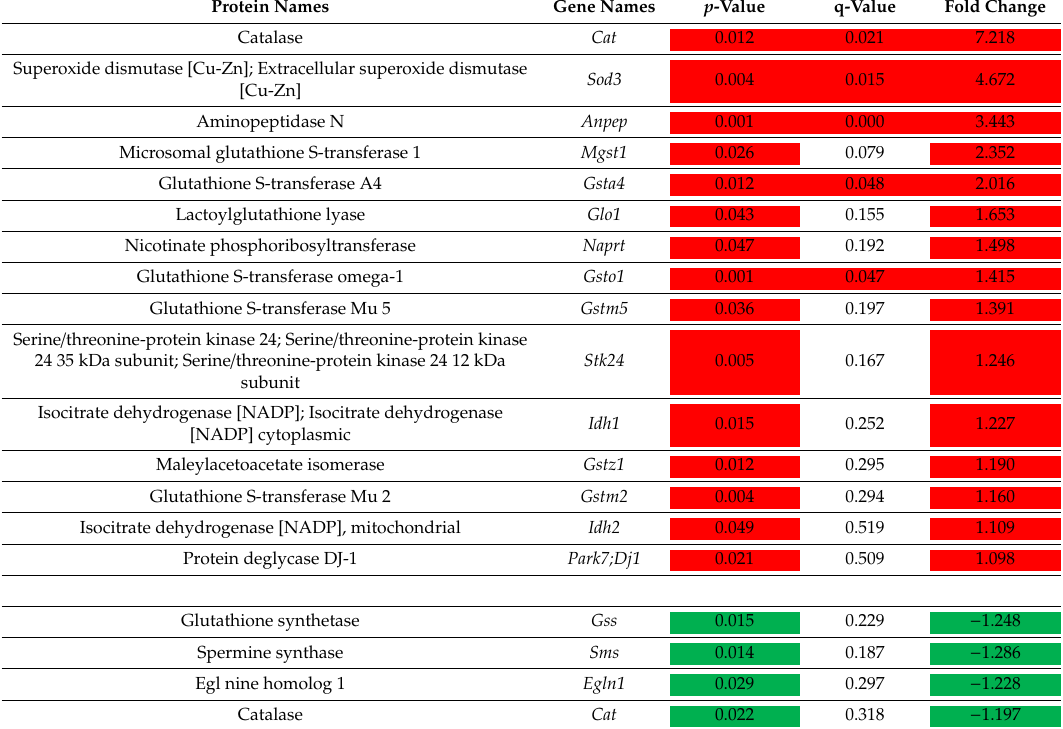
Table 2. List of dysregulated factors in the oxidative stress and antioxidant glutathione pathways, ordered by direction of change (red for upregulations, dark green for downregulations) and by fold-changes. The strongest upregulation was observed for the heme-iron-binding catalase (Cat), while another Cat peptide showed minor